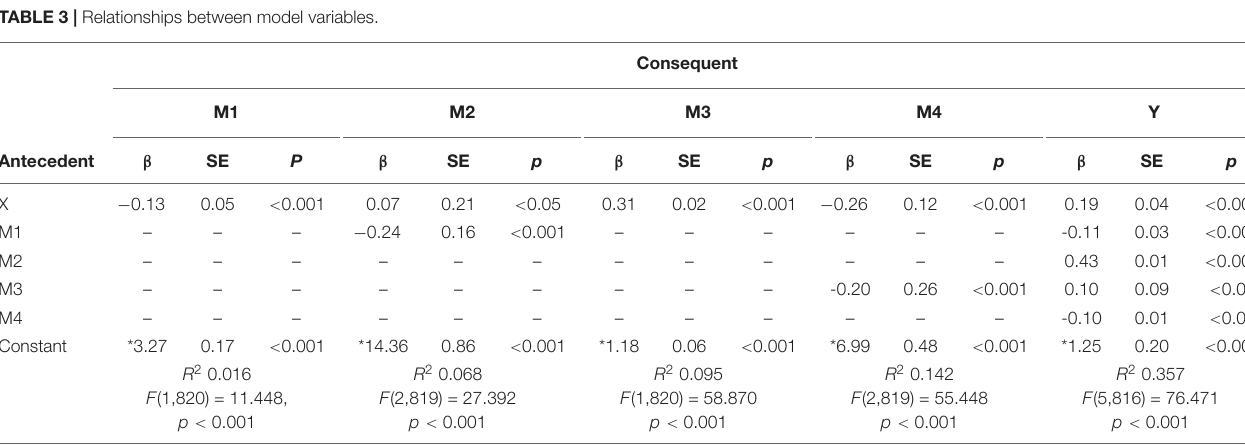
FIGURE 1 | Results of model of multiple mediation in series and in parallel. Note. Values are standardized coefficient. The values in parentheses represent the total effect. ∗ p < 0.05; ∗∗ p < 0.01; ∗∗∗ p < 0.001. TABLE 3 | Relationships between model